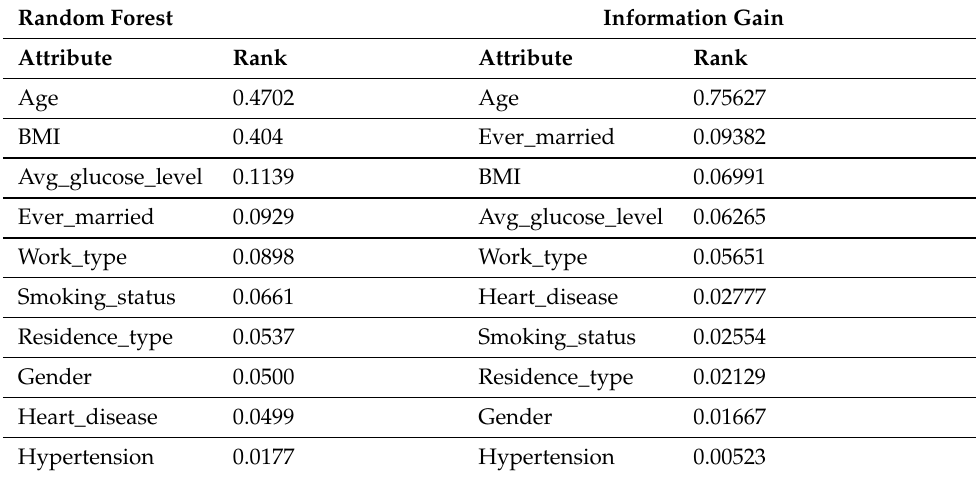
Table 1. Features importance in the balanced